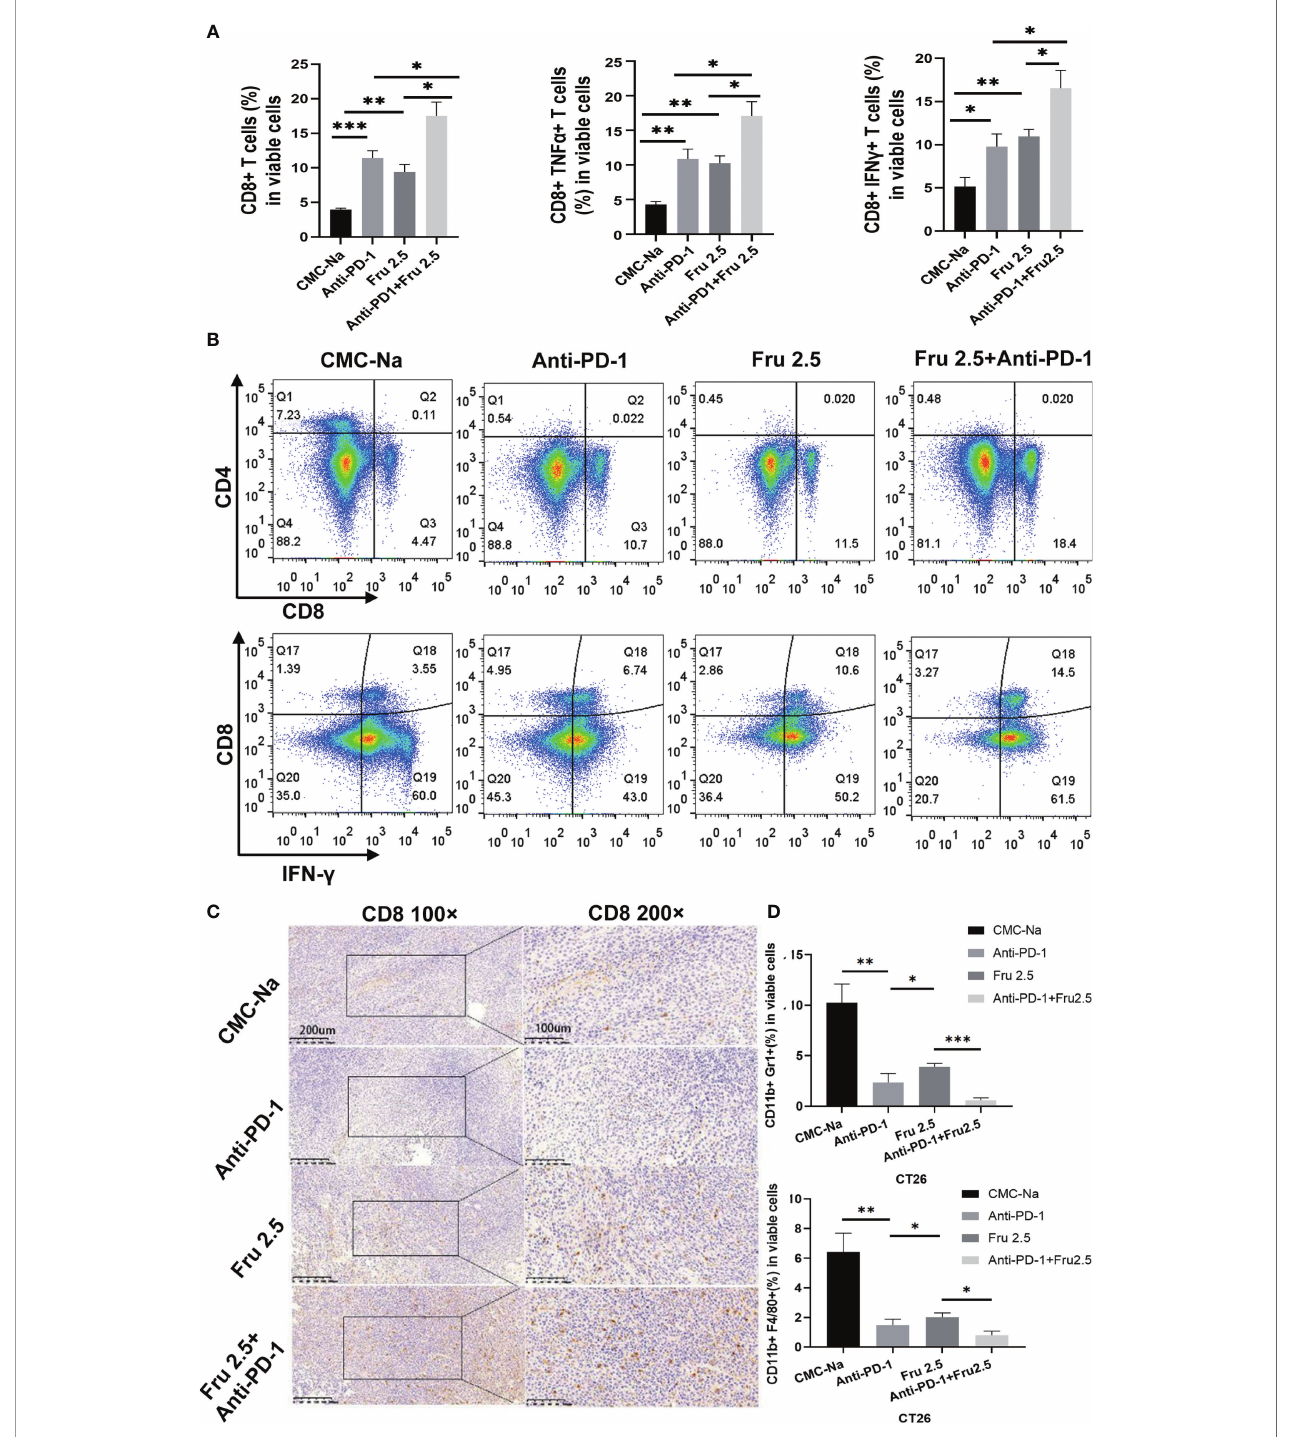
FIGURE 3 | Fruquintinib enhances the effect of sintilimab to reprogram the immune microenvironment and enhance antitumor immunity in CRC. (A) Percentages of CD8 + T cells, CD8 + TNF a + T cells,CD8 + IFN g + T cells in tumor tissues determined by FACS in CT26 tumor-bearing mice treated with indicated drugs (shown as fractions of CD45 + cells) in tumors treated with control CMC-Na, anti-PD-1, Fru2.5, arnti-PD-1 and Fru 2.5, measured by fl ow cytometry at day 14. (B) Representative images of the FACS plots of CD8 + and CD8 + IFN g + CTLs. (C) IHC images for CD8 staining of tumor sections on day14. Scale bar, 200um. (D) Percentage of MDSCs (CD11b + Gr1 + ) and TAM (CD11b + F4/80 + ) in each groups on day 14. *p < 0.05, **p < 0.01, ***p <